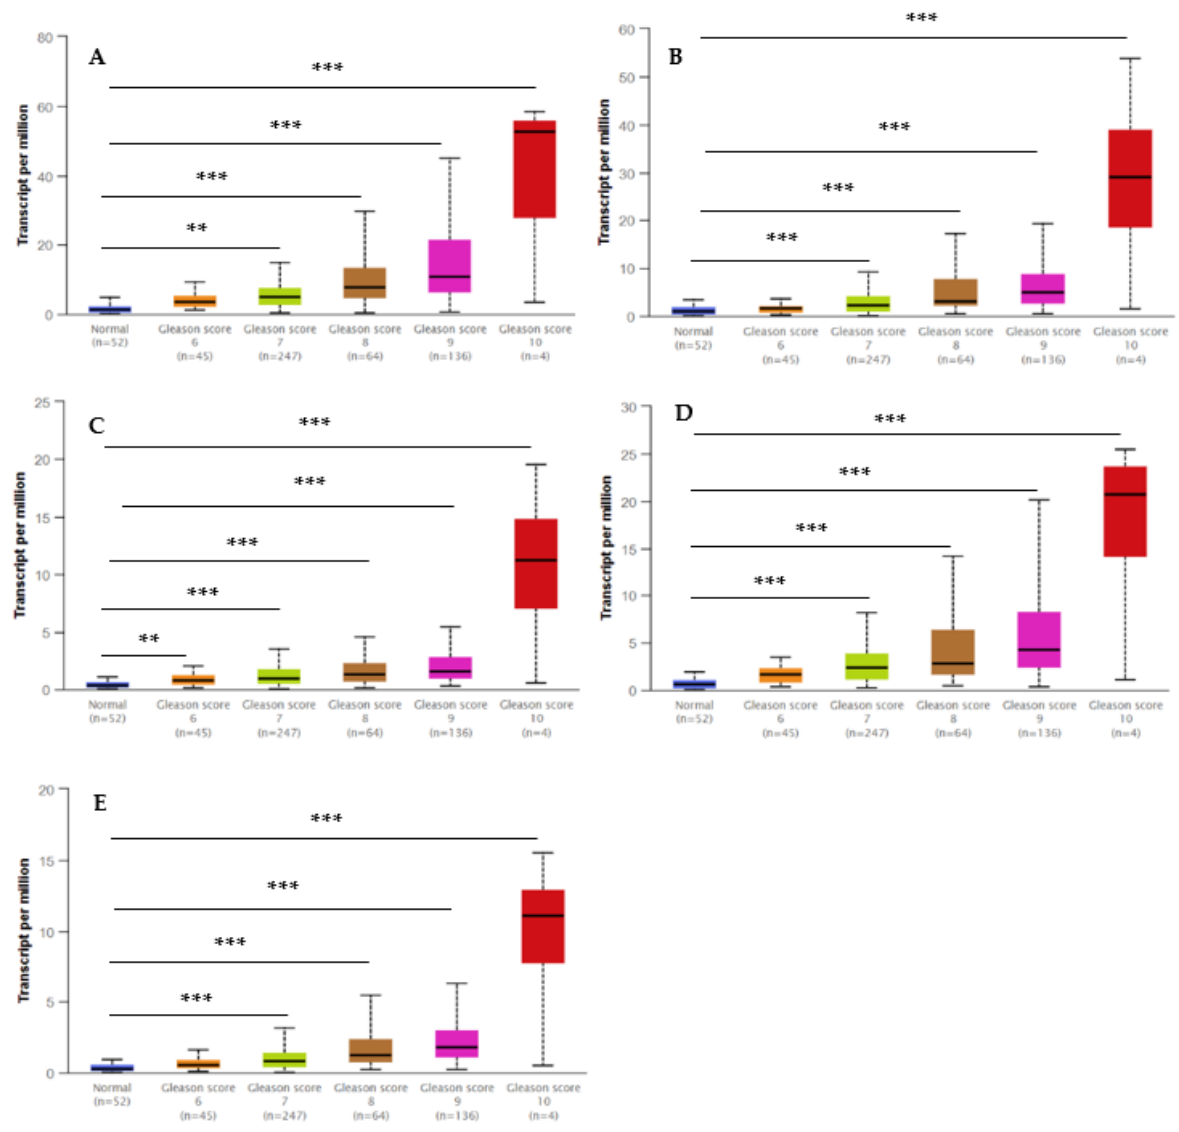
Figure 9. Box whisker plots indicating the different Gleason scores (6, 7, 8, 9, and 10) in the PCa and the normal tissues from the TCGA dataset. Significantly high levels of five hub genes in PCa samples are shown in panels: ( A ) UBE2C; ( B ), TOP2A; ( C ) BUB1B; ( D ) RRM2; and ( E ) CENPF. Data are mean ± SE. ** p < 0.05; *** p < 0.001. mean ± SE. ** p < 0.05; *** p <